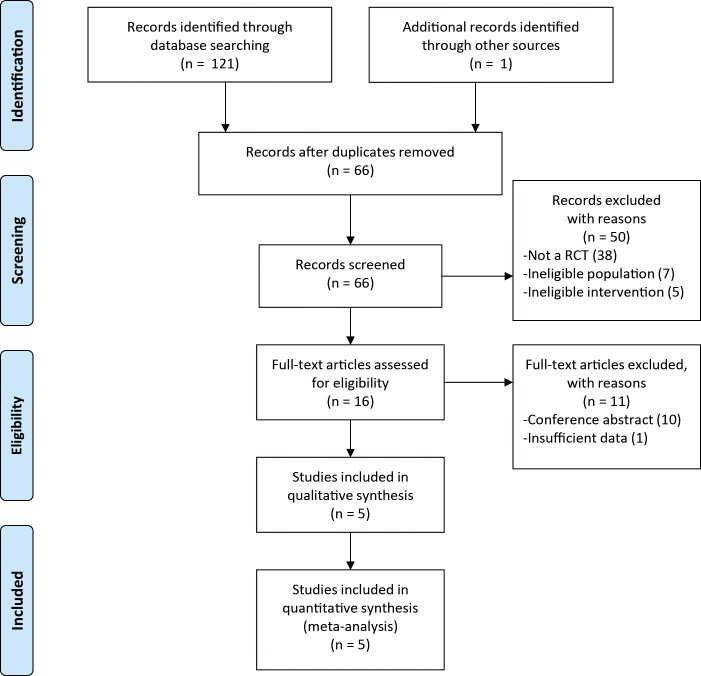
Flow chart of study selection process.